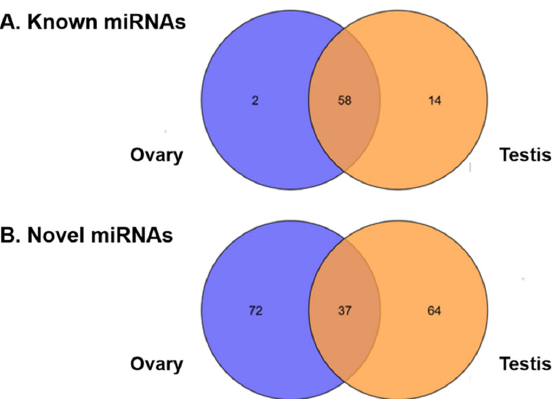
Figure 4. The numbers of the shared and testis- or ovary-specific known ( A ) and novel ( B ) miRNAs expressed in the gonads of a 0-day-old male adult and a 2-day-old female adult of H. armigera .